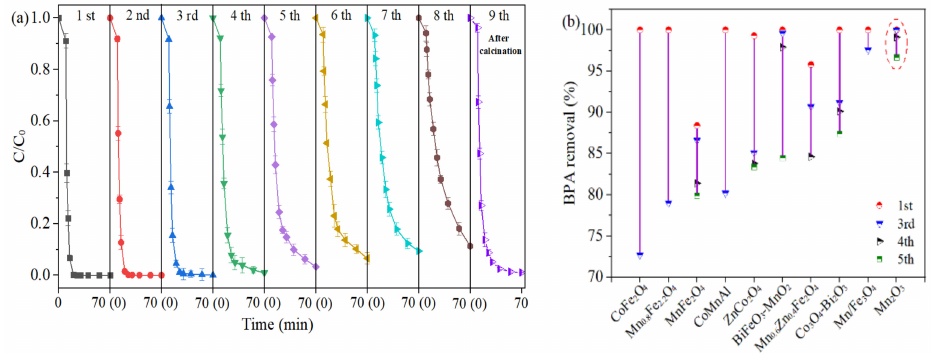
Figure 10. Reusability of Mn 2 O 3 and lab-made catalysts reported in literature. ( a ) BPA degra- dation in eight consecutive runs with the Mn 2 O 3 /PMS oxidation system (reaction conditions: [BPA] 0 = 10 mg/L, [PMS] 0 = 0.10 mM, [Mn 2 O 3 ] 0 = 0.2 g/L, initial pH = 7.0 ± 0.2, the first 10